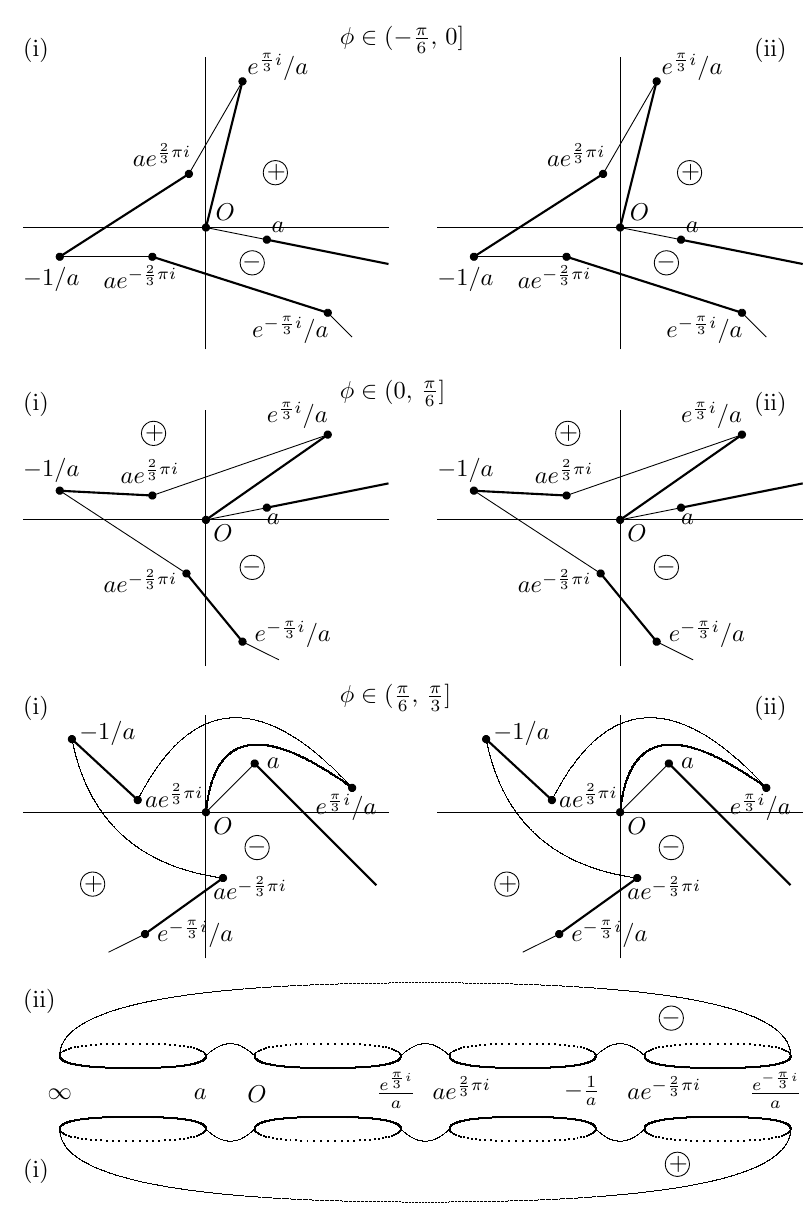
Figure A1. M represented as a two-sheeted branched cover of C .